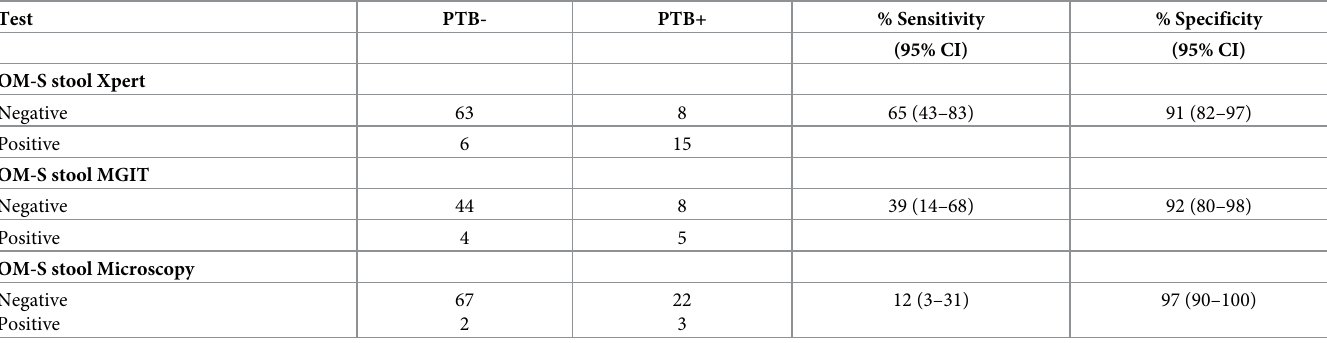
Table 4. Performance of OM-S stool Xpert MTB/RIF Ultra, MGIT, and Smear microscopy among sputum smear negative samples.